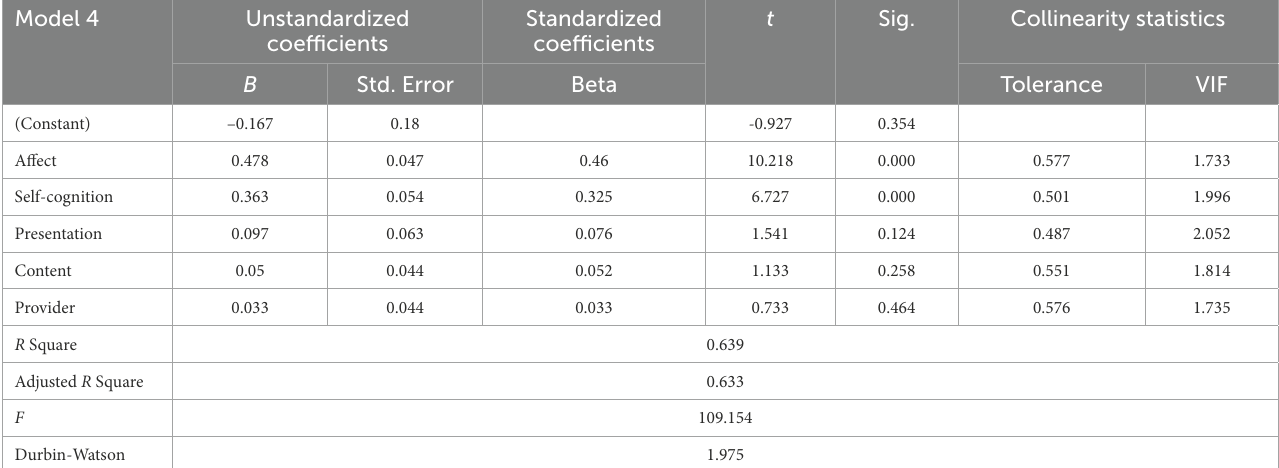
TABLE 8 Regression analysis of predictive variables and conation (b). a